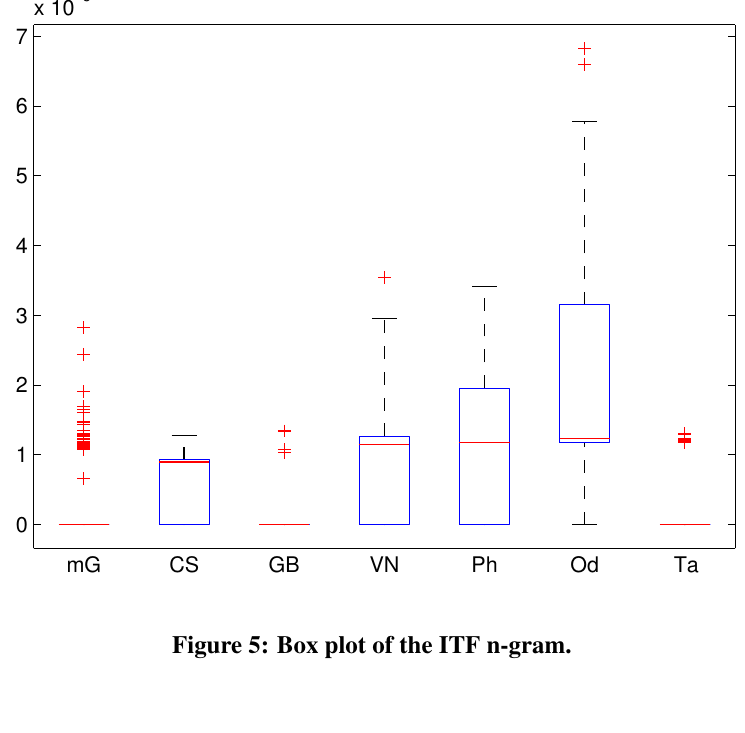
Figure 5: Box plot of the ITF n-gram.